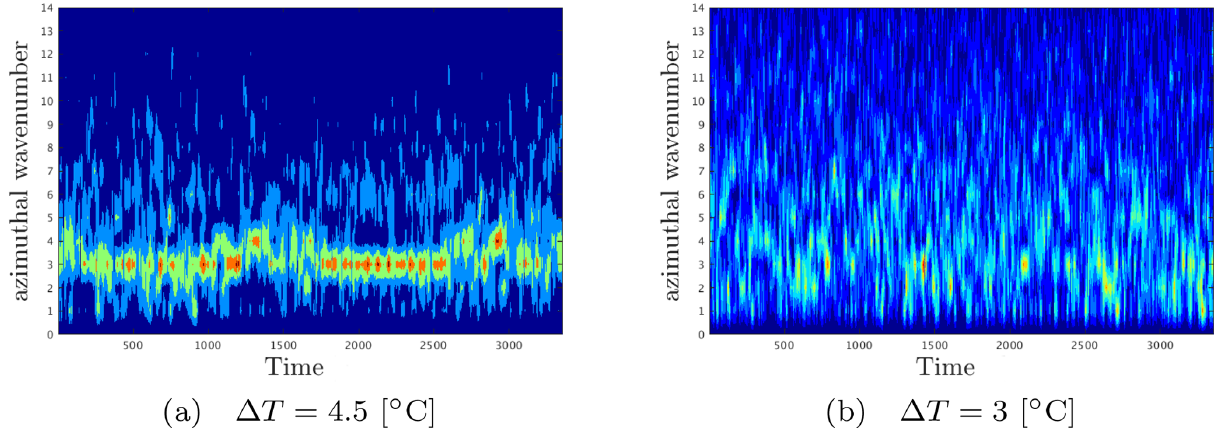
Figure 4. Azimuthal wavenumber evolution over time for experiments C15 (a) and C18 (b) . The colour map represents the Fourier transform of temperature data sampled at a constant radius r 0 = 0 . 063m. Larger (cid:49)T values are associated with flows with a dominant wavenumber where sporadic transitions occur over time (a) . When (cid:49)T is decreased, the flow is irregular as a result of a superposition of wavenumbers (b) .